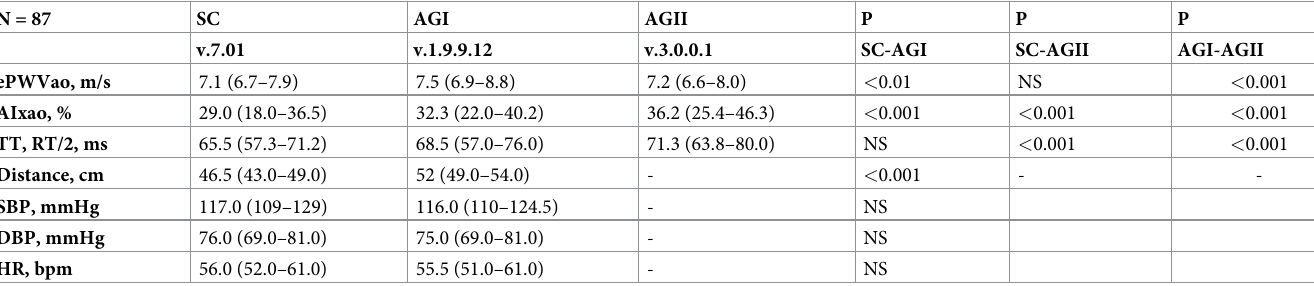
Table 1. Vascular data measured by SphygmoCor and